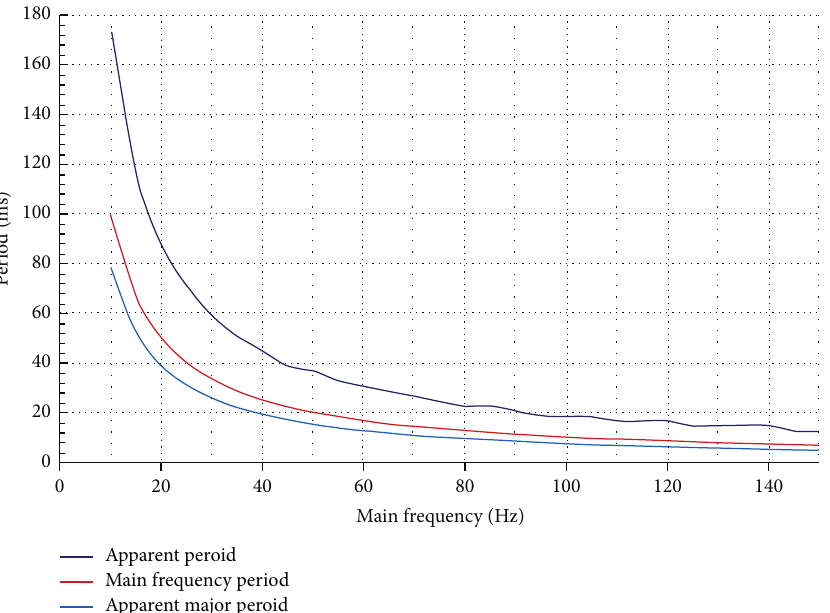
Figure 9: Change relations between the three periods and the main frequencies.